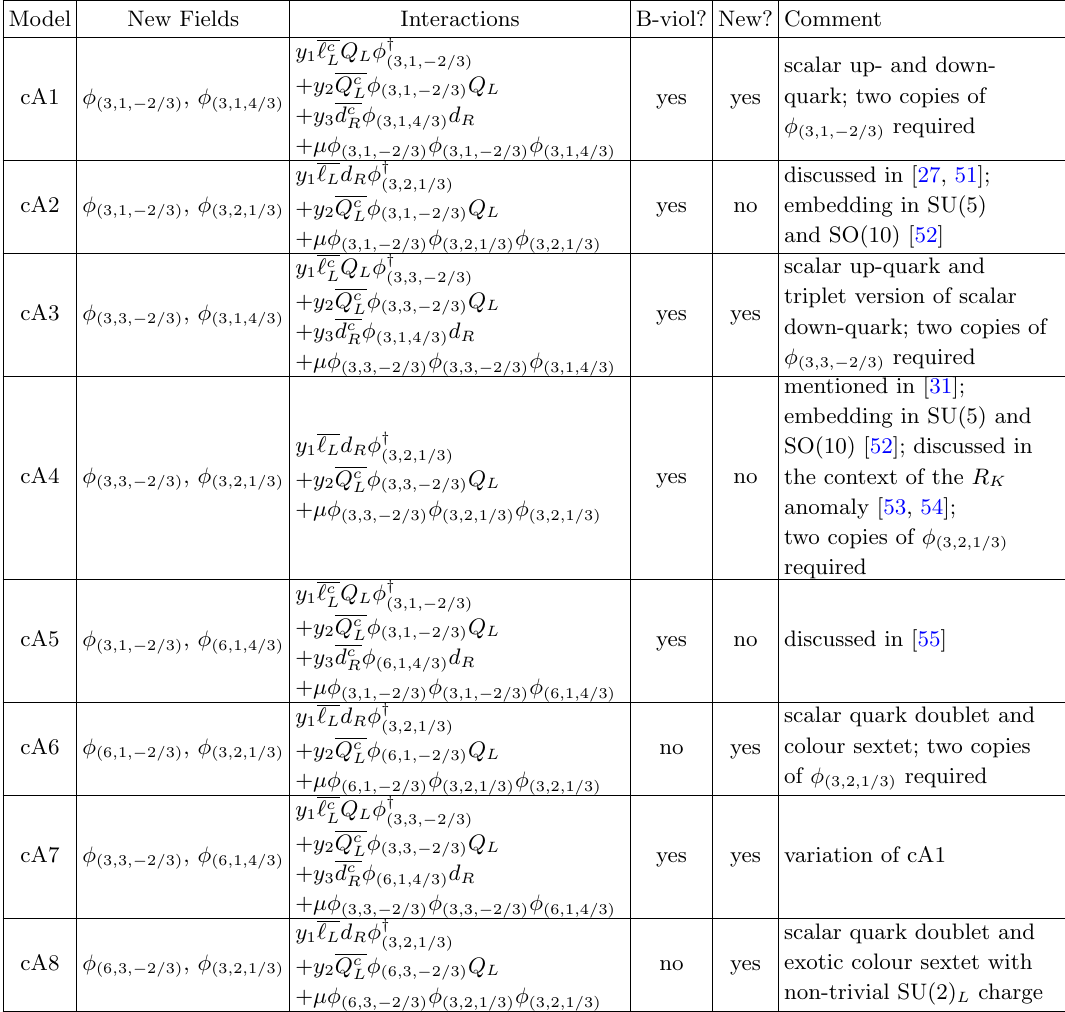
List of neutrino mass models with two new scalars including non-trivial SU(3) C -